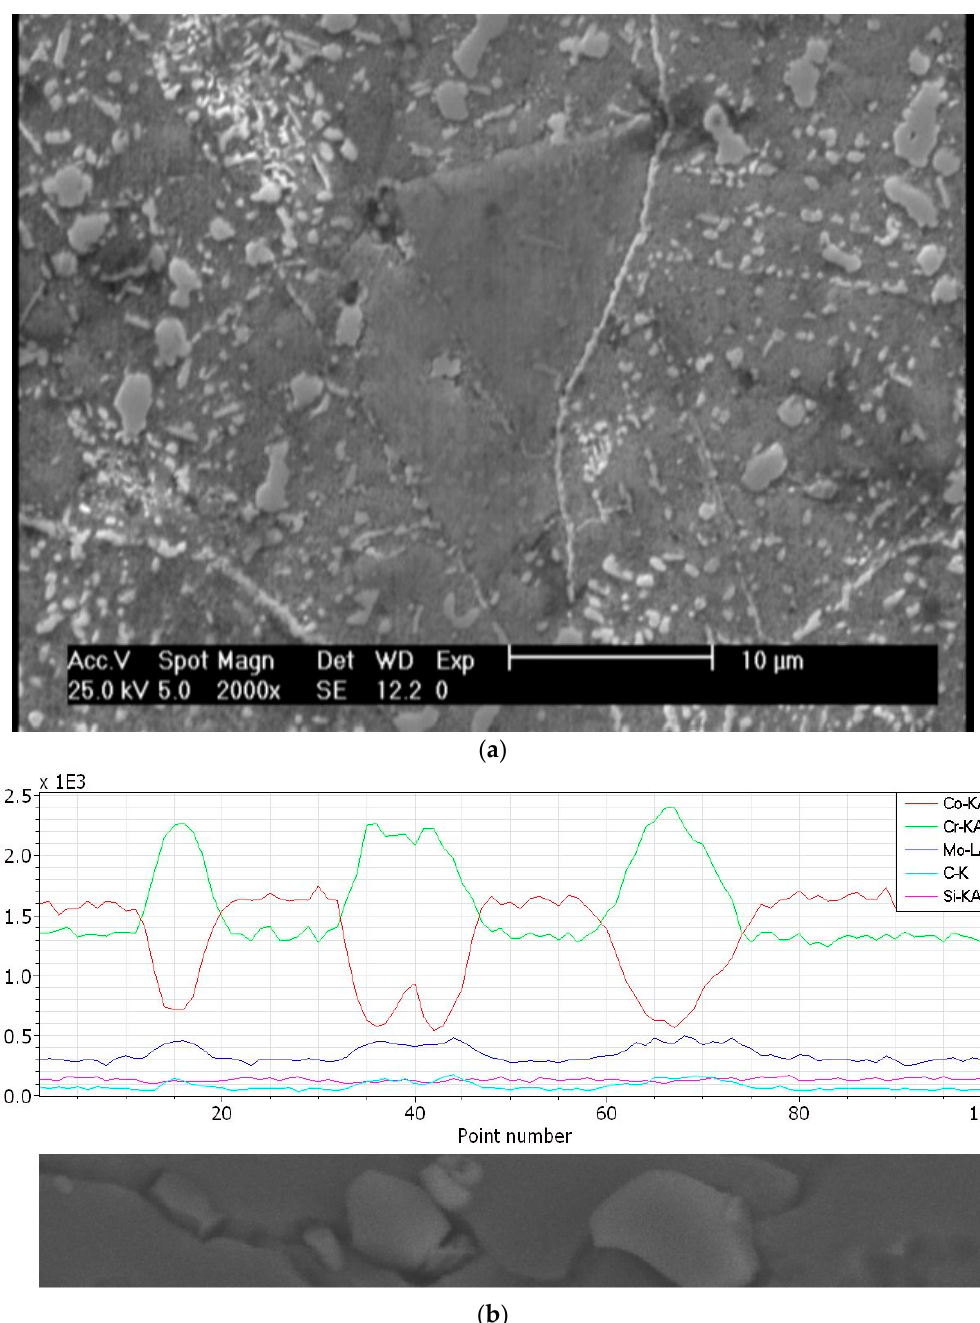
Figure 8. SEM micrographs of the partially solution treated sample, that was aged at 850 °C for 48 h, ( a ) un-dissolved primary carbides, ( b ) EDS analysis of the un-dissolved carbides along a line transmits within the un-dissolved carbides.